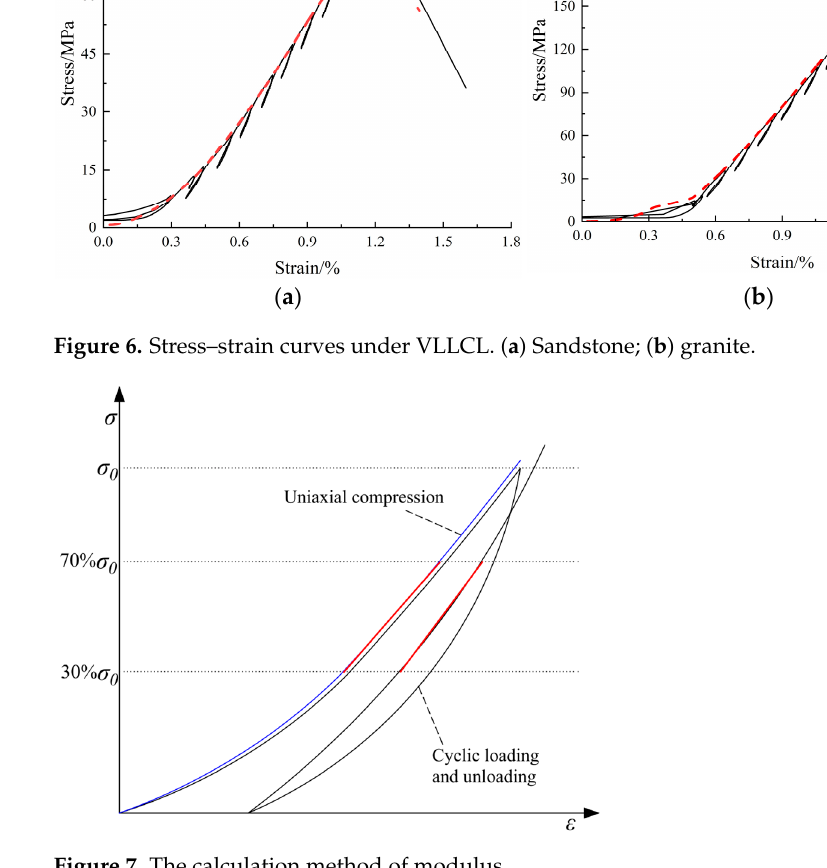
Figure 6. Stress–strain curves under VLLCL. ( a ) Sandstone; ( b ) granite.